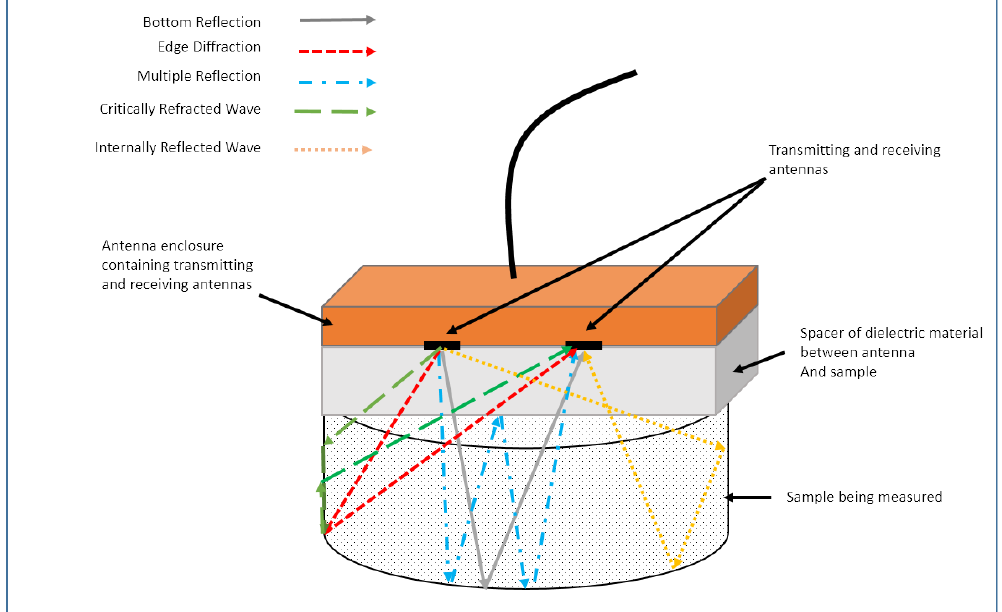
Figure 11. Cut-away view showing the ray paths indicating sources of major reflections and diffractions arriving from bottom and sides of the sample being measured.